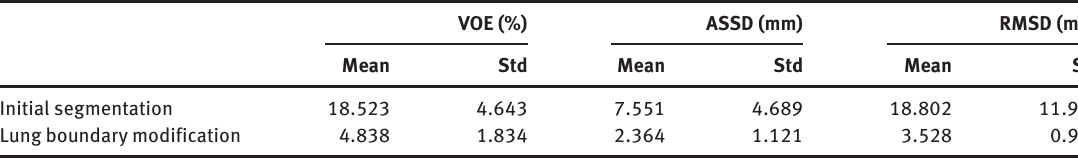
Table 3: Proposed Segmentation Method Evaluation Results in Two